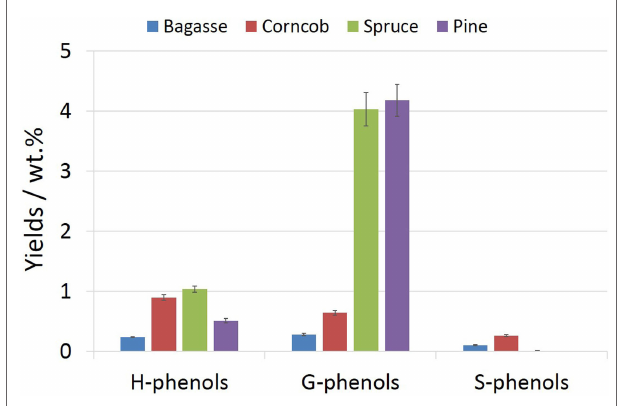
FigUre 3 | Distribution of phenols in the different bio-oils